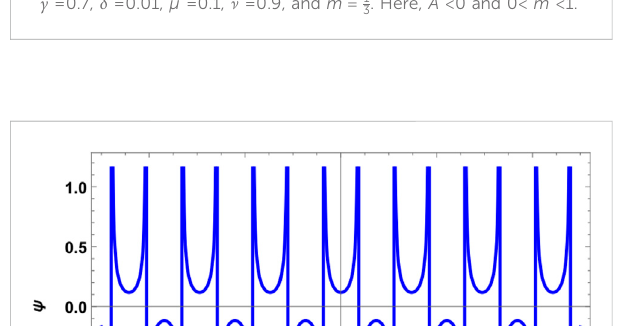
. Here, A < 0 and 0 < m < 1. 3